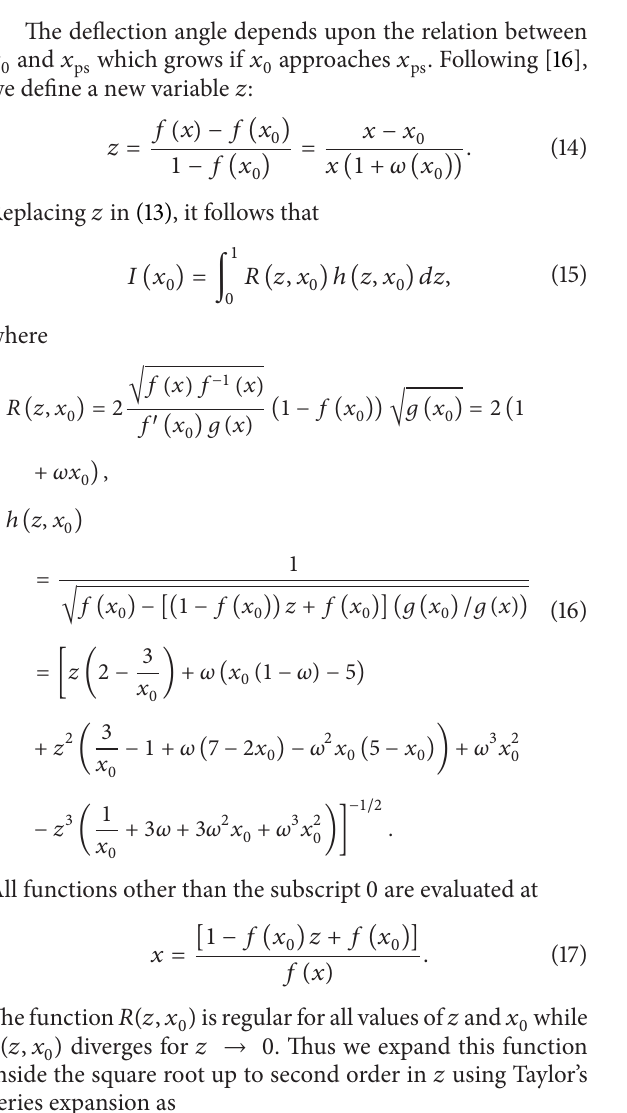
Figure 2: Radius of photon sphere ( 𝑥 string parameter 𝜔 . Red curve corresponds to 𝑥 line (dashed) indicates Schwarzschild